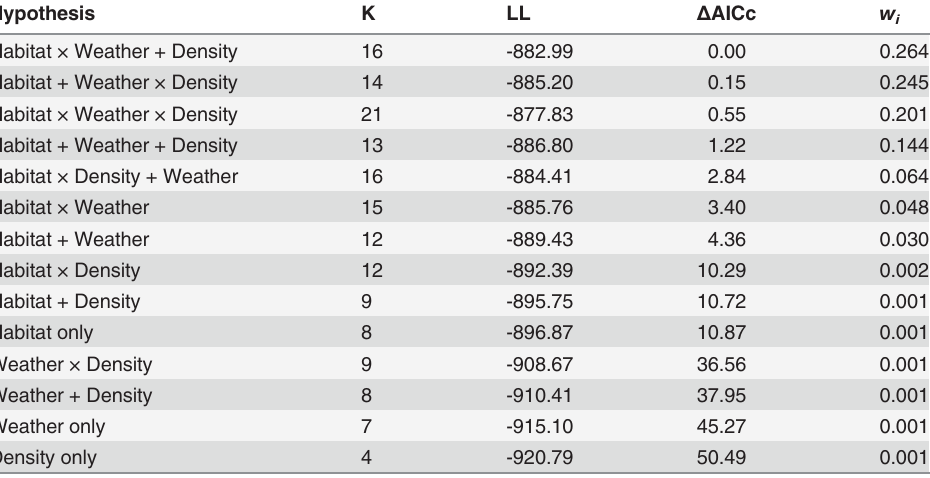
Table 6. Rankings of models that described the individual, additive, and interactive effects of spatial and temporal factors and conspeci fi cs on reproductive output of ferruginous pygmy-owls in northwest Mexico, 2001 – 2010. Hypothesis K LL Δ AICc w i Habitat × Weather + Density 16